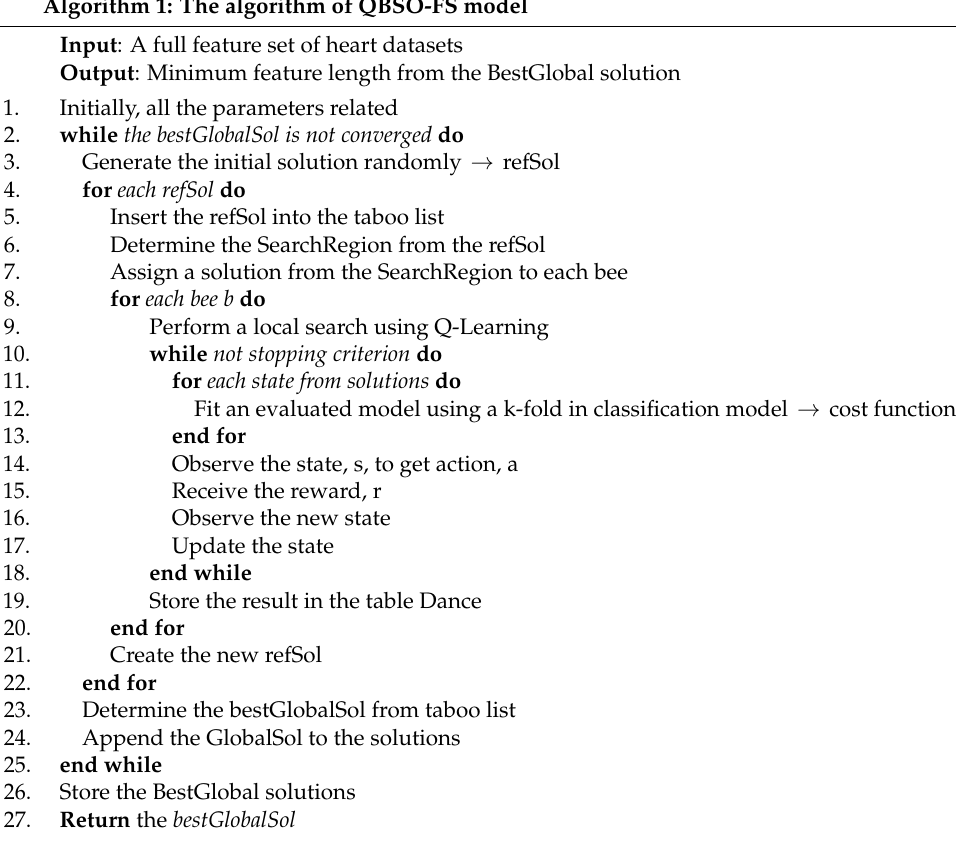
Algorithm 1: The algorithm of QBSO-FS